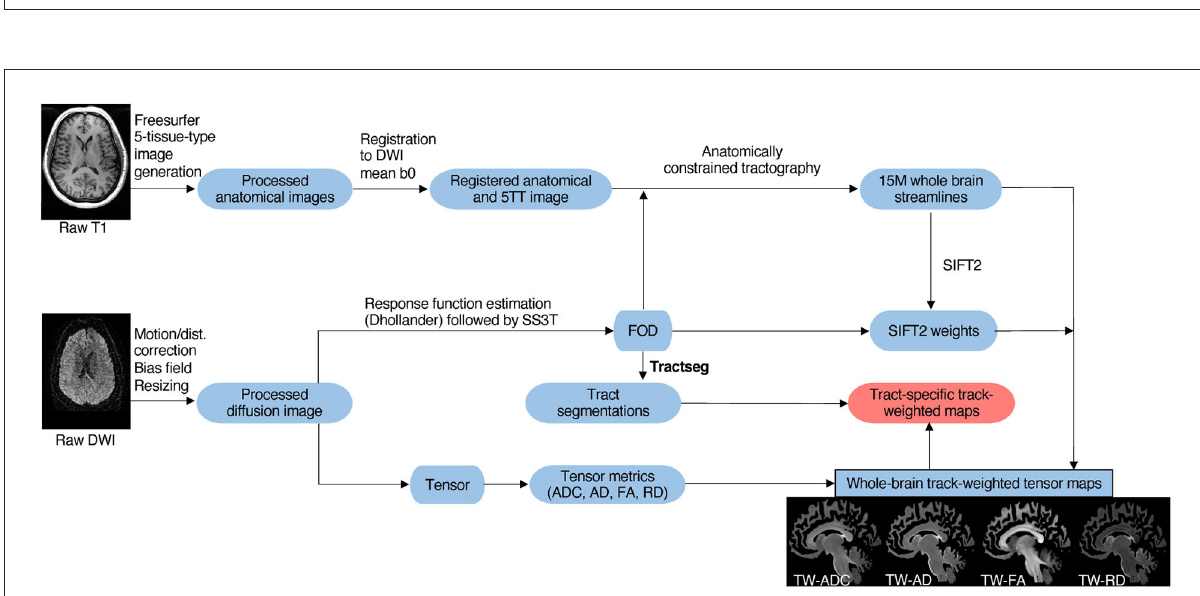
FIGURE2 Schematic overview of imaging analysis pipeline. As described in Section 2.3, T1 and diffusion MRIs were preprocessed. Next, tract generation and subject-specific tract segmentation was conducted. Lastly, tensor maps were produced, and the tract-specific, track-weighted tensor-based measurements were